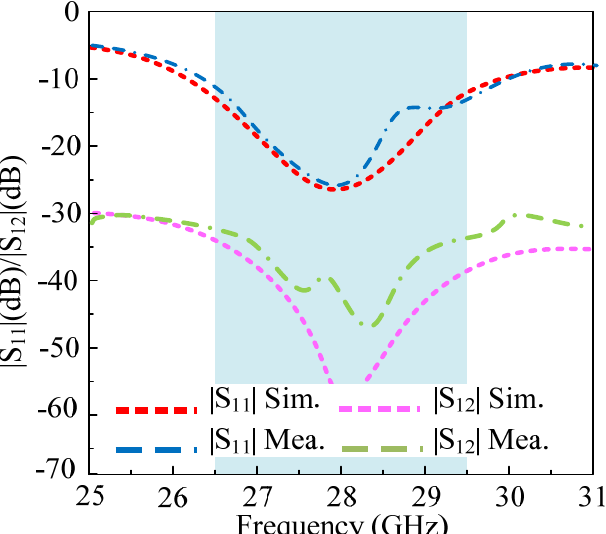
Figure 9. Comparison between measure and simulated results of proposed antenna in form of Reflection and transmission coefficient.